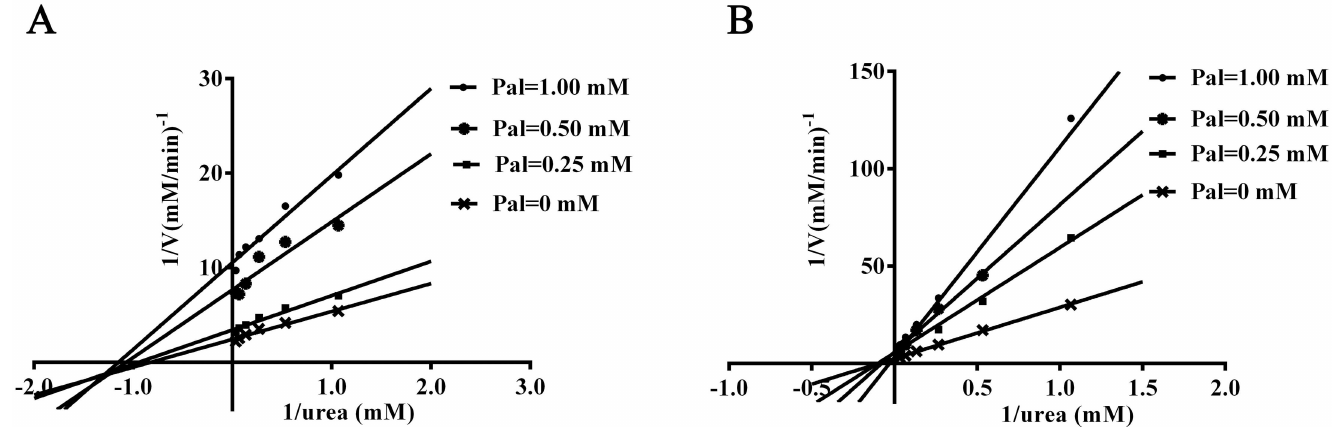
Fig 3. Lineweaver-Burkplots of HPU (A) and JBU (B) inhibition by Pal versus reciprocal of substrate concentrations (0.3125–15mM) in the absence or presenceof 1.00, 0.50, and 0.25 mM Pal. The concentrations of both ureaseswere 0.25 mg/mL. Data were expressedas means ± SD from three independent